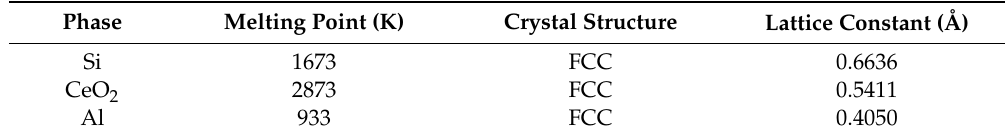
Table 1. Basic physical parameter of Si, CeO 2 and